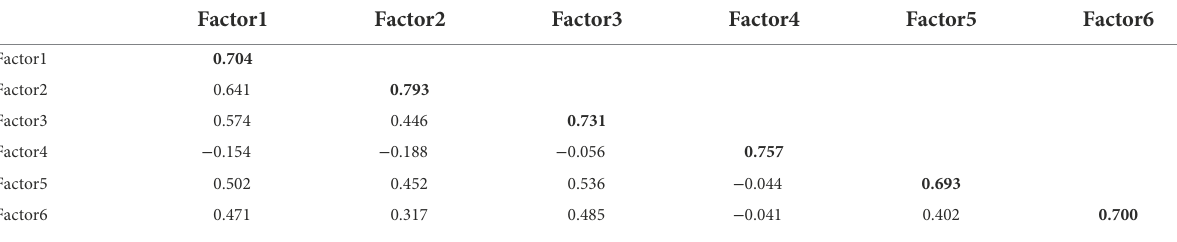
TABLE 4 Discriminant validity: Pearson correlation vs. AVE square root value.